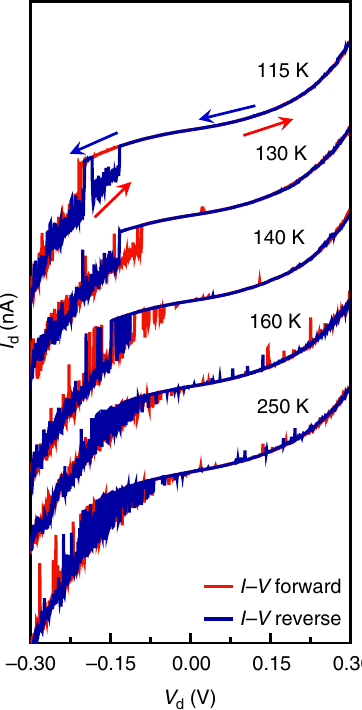
Fig. 2 I – V characteristics of TTDA molecular junctions at different temperatures. The devices were measured in the dark and under vacuum. Stochastic switching mainly occurred at the negative bias voltages. The gate voltage is 0